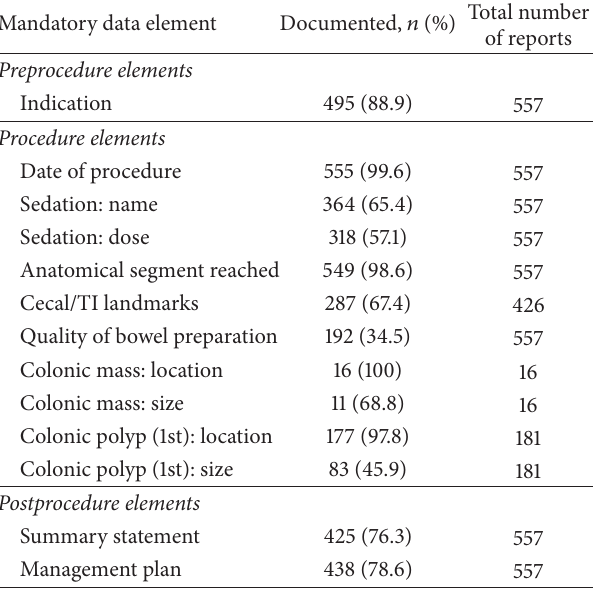
Table 1: Number and proportion of mandatory data elements documented among CS reports ( 𝑁 = 557